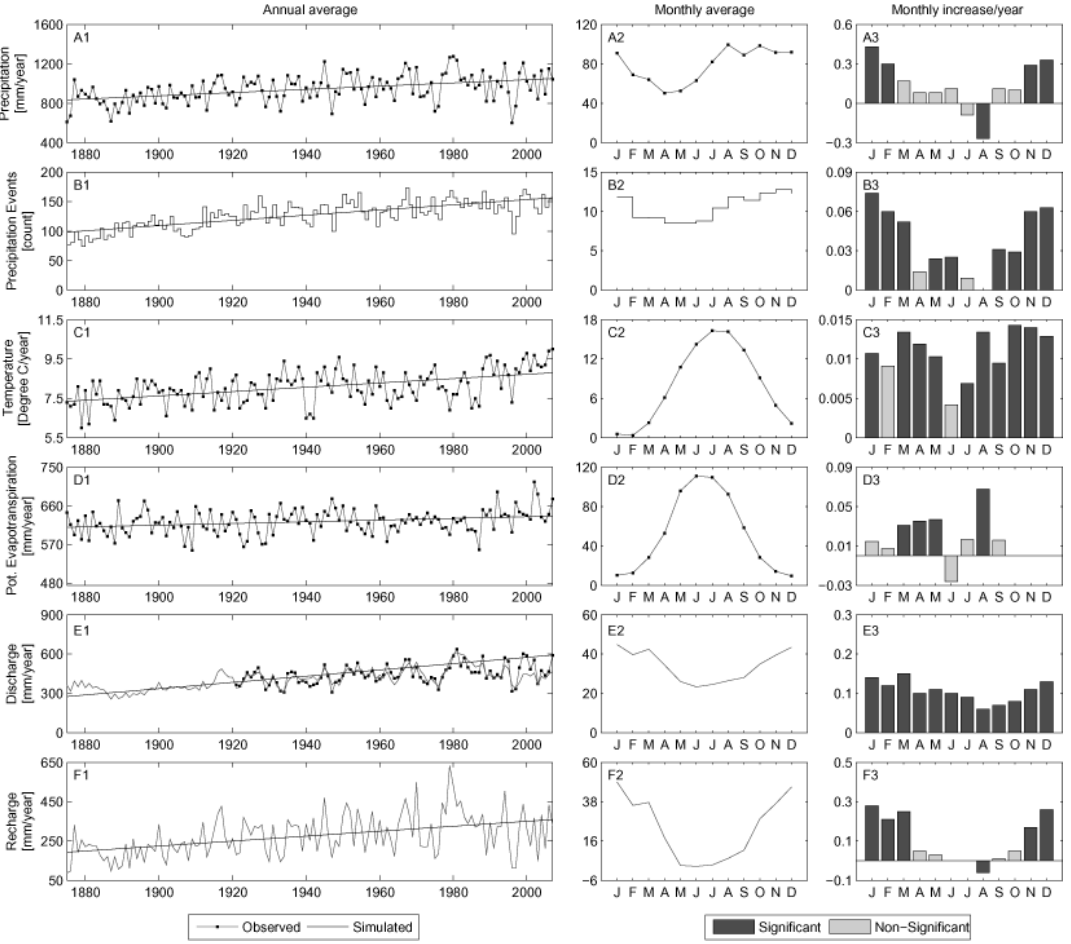
Fig. 5. Information about the variables: precipitation in mm (A) , precipitation events in count per year (B) , temperature in degree Celsius (C) , potential ET in mm (D) , stream discharge in mm (E) and groundwater recharge in mm (F) . Left panel (A1-F1) : annual average. Centre panels (A2-F2) : monthly averages. Right panel (A3-F3) : monthly distribution of the increase or decrease for each component of the water balance. Table 5. Results from calibration of the NAM model against observed discharge from each individual 10yr period (WB – relative water balance; RMSE – root mean square error; NSE – Nash–Sutcliffe coefficient; r – correlation coefficient; EI – error index). Parameters Objective function Performance parameters Period U max L max CQOF CK 1 . 2 CKBF